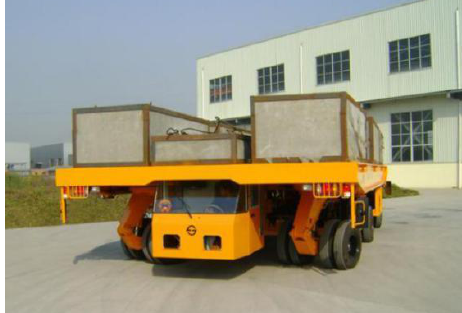
Figure 13. The experiment in the field.